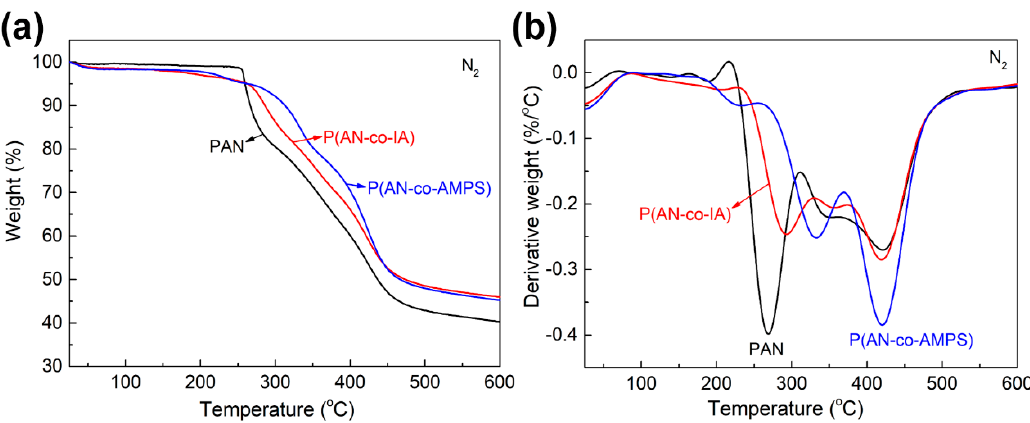
Figure 8. Thermogravimetric analysis (TGA) ( a ) and derivative thermogravimetric (DTG) ( b ) curves of PAN, P(AN-co-IA), and P(AN-co-AMPS) nanofibers under the N 2 atmosphere, respectively.